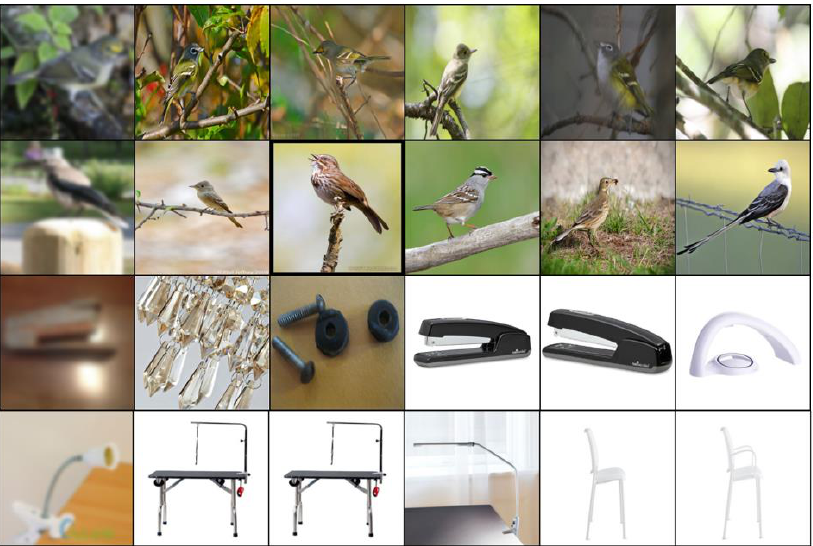
Figure 1. Failure cases when querying a retrieval system using low-resolution images. The base model is EfficientNet-b7 with features extracted from the last convolutional layer. The first image of each round is the query, and the next five images are the top 5 retrieval results, with labels of some images different from the label of the query image. Images in the first two rows belong to the CUB200-2011 dataset, while those of the last two rows belong to the Stanford Online Product dataset. First row: 1st image is query image from class “mourning warbler “, 2nd image from class “magnolia warbler”, 3rd image from class “yellow-throated vireo”, 4th image from class “white- crowned sparrow”, 5th image from class “blue-headed vireo”, 6th image from class “yellow-throated vireo”. Second row: 1st image is query image from class “Clark nutcracker”, 2nd image from class “Western Kingbird”, 3rd image from class “song sparrow”, 4th image from class “American pipits”, 5th image from class “blue-headed vireo”, 6th image from class “scissor-tailed flycatcher”. Third row: 1st image is query image from class “stapler “, 2nd image from class “lamp”, 3rd image from class “cabinet“, 4th and 5th images from class “stapler”, 6th image from class “kettle”. Fourth row: 1st image is query image from class “lamp “, 2nd and 3rd image from class “cabinet”, 4th image from class “lamp”, 5th and 6th images from class